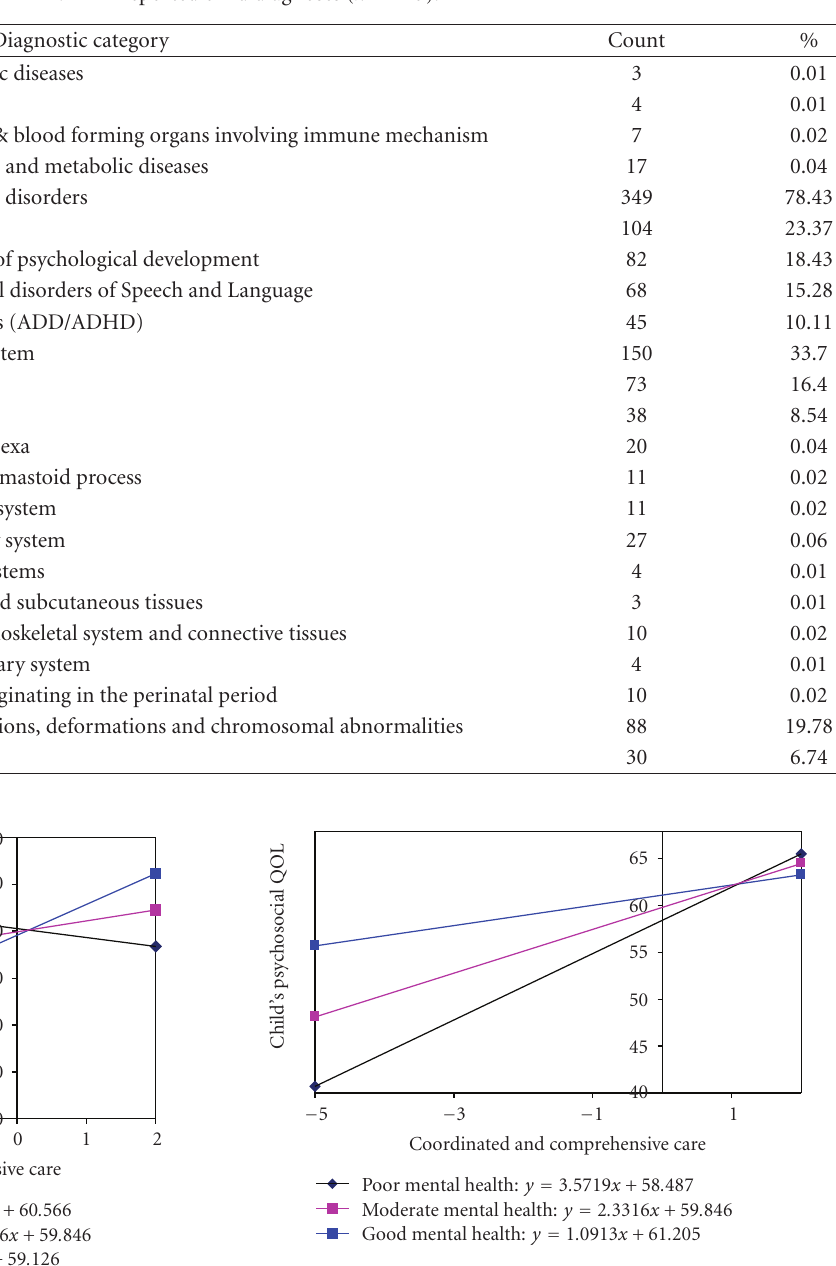
Table 2: PMK reported child diagnoses ( n = 445).